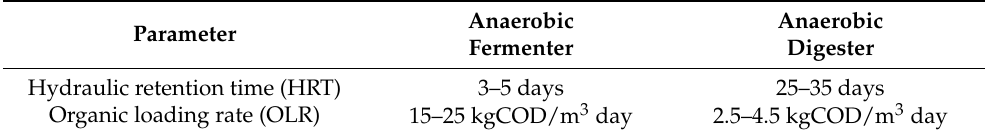
Table 1. Operational conditions of the anaerobic acidogenic fermenter and anaerobic digester.